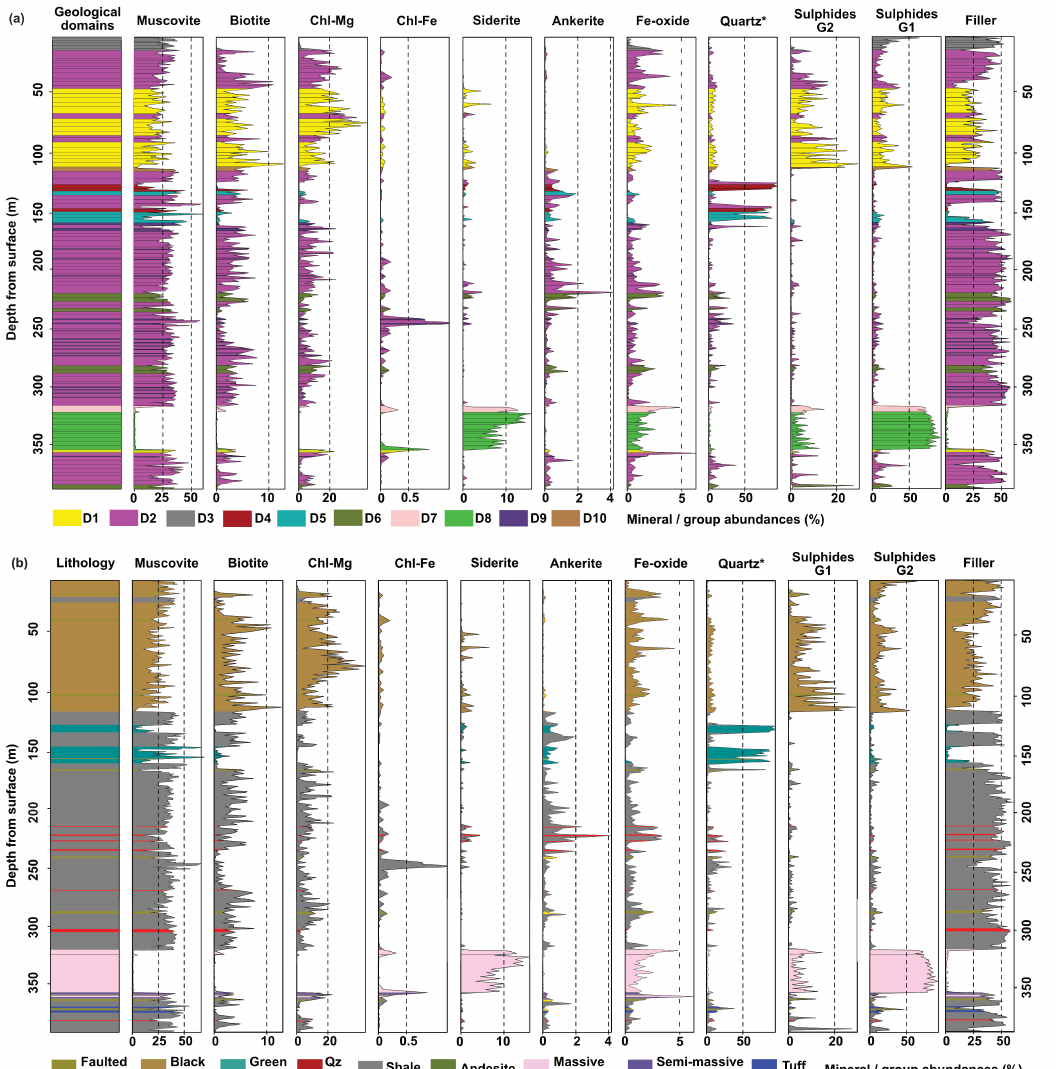
Figure 8. ELV-10 Borehole represented by the mineral abundance estimations of: Muscovite, Biotite, Magnesium-rich Chlorite, Iron-rich Chlorite, Siderite, Ankerite, Iron oxide, Quartz, Sulfides Group 1 and Sulfides Group 2 used as input data. The filler column comprises the sum of nine additional minerals (accessory and/or visible, near infrared and shortwave infrared spectrally inactive and accessory minerals). The first column in each sub figure guides the color scheme and represents ( a ) the lithology log from the mining company ( b ) the geological domains derived from the hyperspectral data by the proposed methodology extracted at a scale of